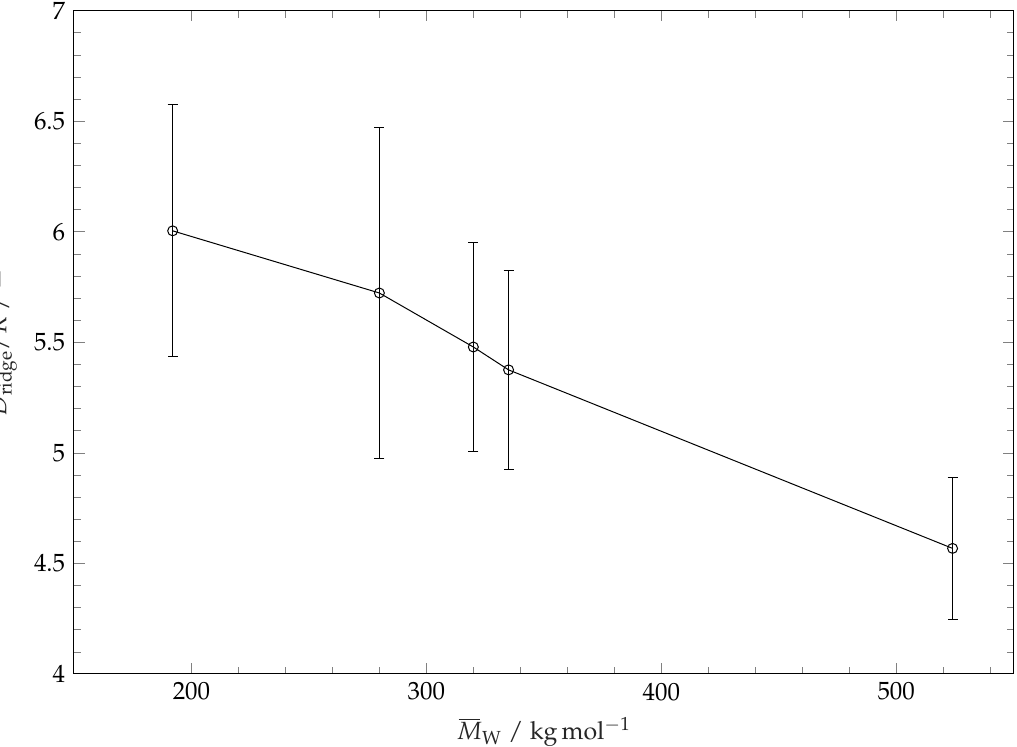
Figure 11. Ridge line diameters after wetting and evaporation of solvent droplets on different substrates. For comparability, ridge line diameters are divided by the initial solvent droplets radius R . The error bars represent the standard deviation of the mean values.